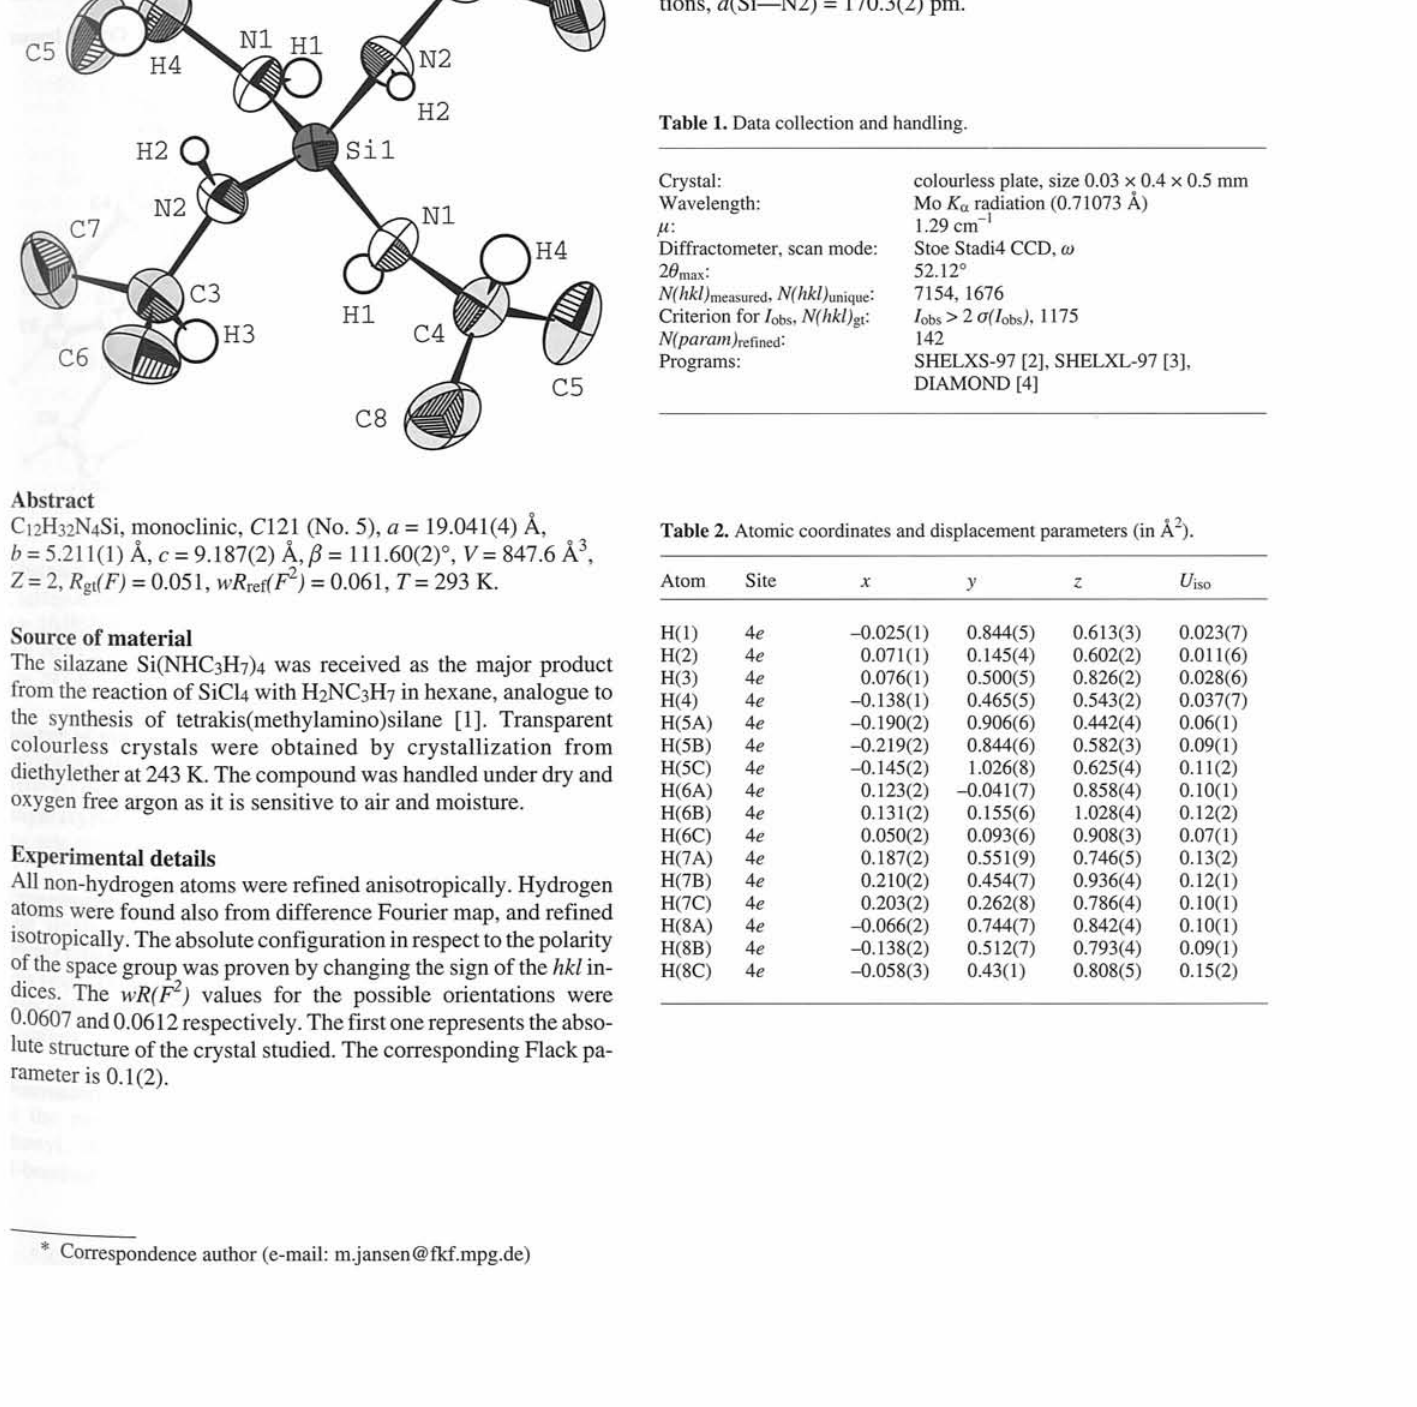
Table 1. Data collection and handling.